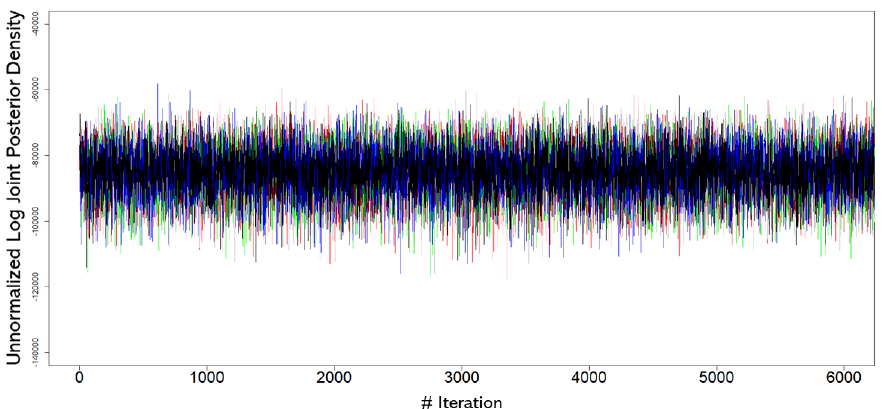
Figure 3. Trace plot of the (unnormalized) log posterior density computed for all the chains, for the first 6000 iterations. The burn-in period was removed to show the whole convergence dynamic. As can be noticed, the log posterior seems to show no trends.